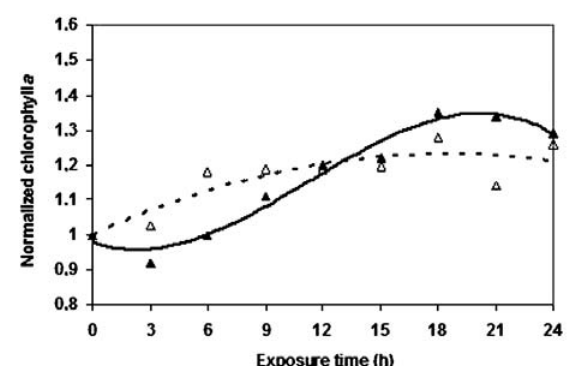
Fig . 2. – Time course of Chl a (normalized to initial values) dur- ing exposures: Sfixed surface (filled triangles) and vertical mixing (open triangles).